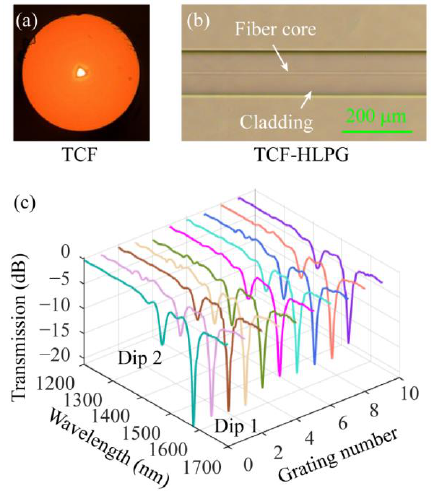
Figure 8. ( a ) Microscopic image of the cross-section of the TCF. ( b ) The microscopic image of the partial TCF-HLPG. ( c ) Transmission spectra of different TCF-HLPG samples.